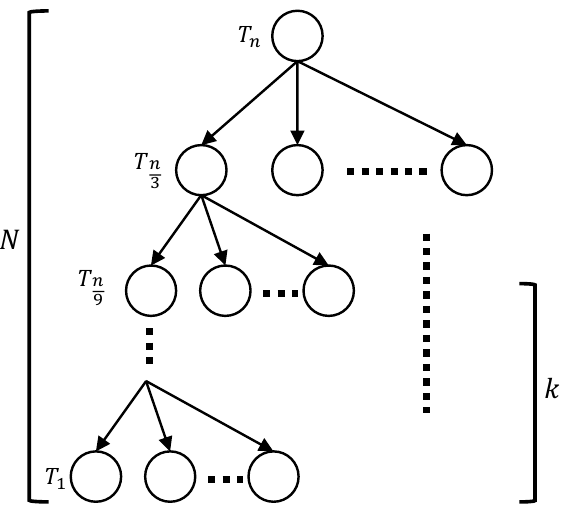
Figure 1. Recursion tree structure of the Toom-3